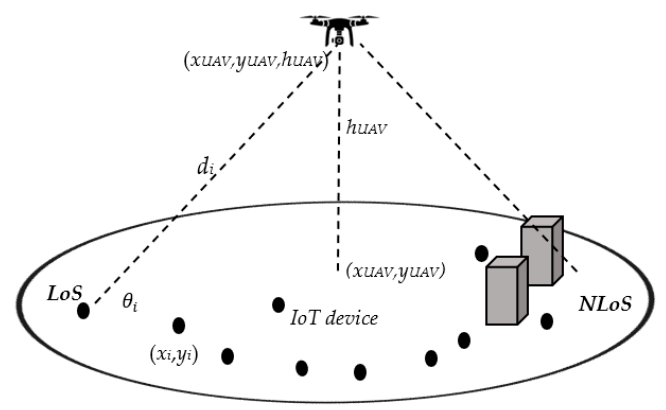
Figure 1. Illustration of the elevation angle in case of static UAV [21].